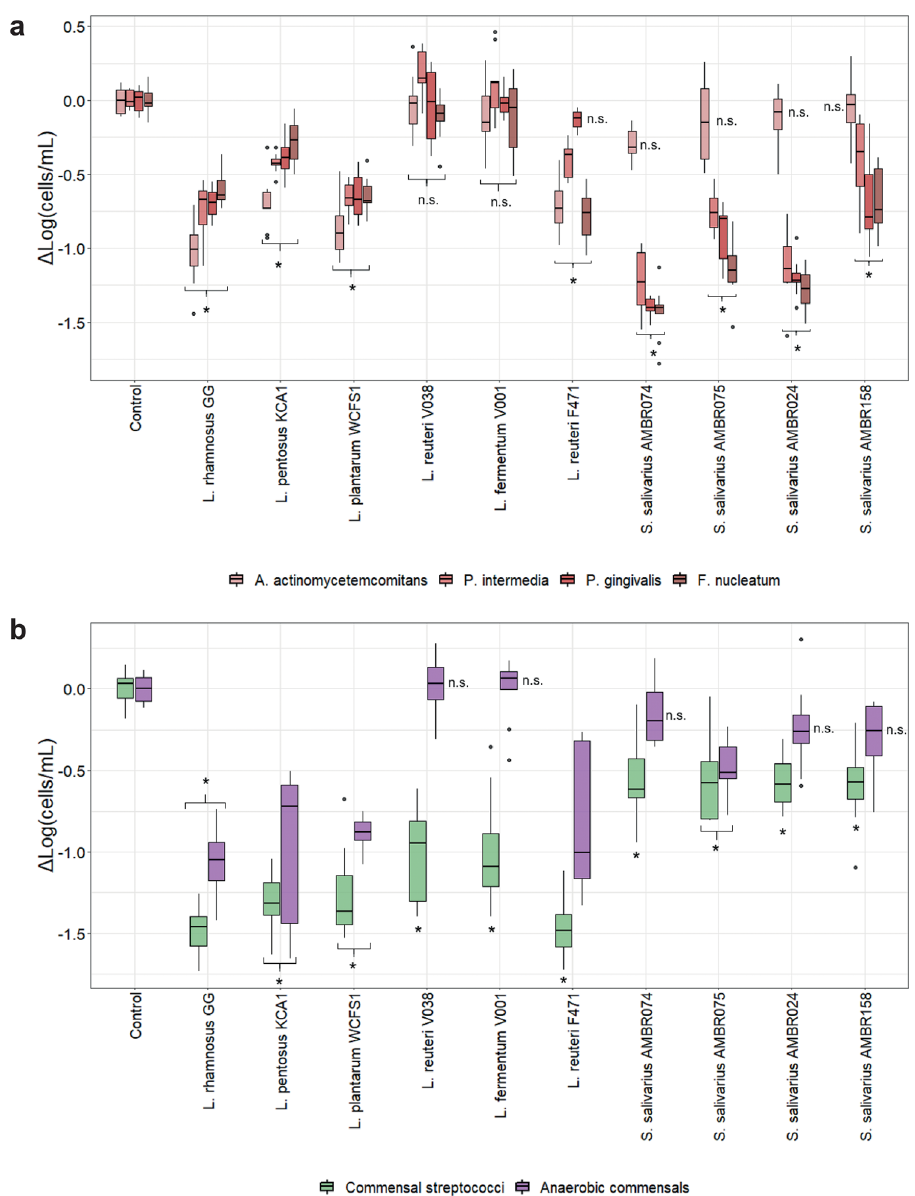
Fig. 3 Probiotic effects on oral bacteria in bio fi lms. Changes in prevalence of ( a ) pathobionts and ( b ) commensals in multispecies bio fi lms caused by the addition of the probiotic candidates during bio fi lm formation. Relative changes in abundance are presented as a boxplot of the change in log 10 cells per milliliter (log(cells/mL)) from the control (Tukey style boxplot with median centre line, IQR at 1.5, upper and lower hinges at 25th and 75th percentiles and whiskers at 1.5 IQR from the hinges). n.s.: nonsigni fi cant from control bio fi lm. Statistically signi fi cant differences from the control bio fi lm are depicted as an asterisk ( n = 9, ANOVA with Tukey